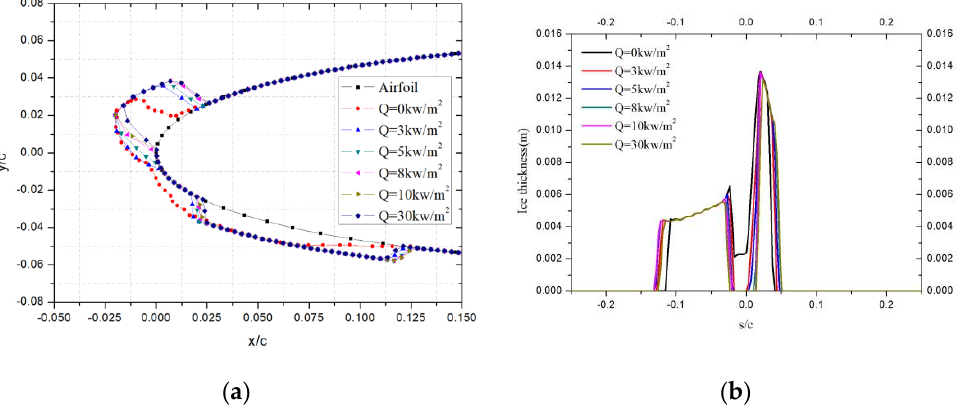
± 0.02: ( a ) Ice shapes; ( b ) Ice thickness.